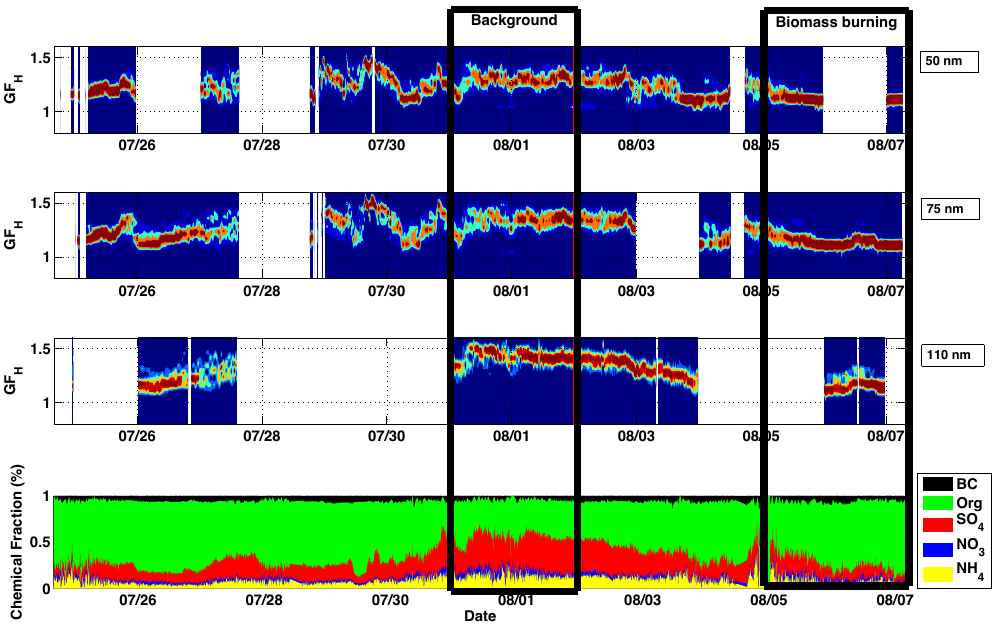
Fig. 2. Time series of hygroscopic growth factor distribution (GF-PDF) for 50nm, 75nm and 110nm-sized particles (three upper panels), and mass fraction of chemical components in particles (lower panel) from period between 24 July 2010 and 7 August 2010.